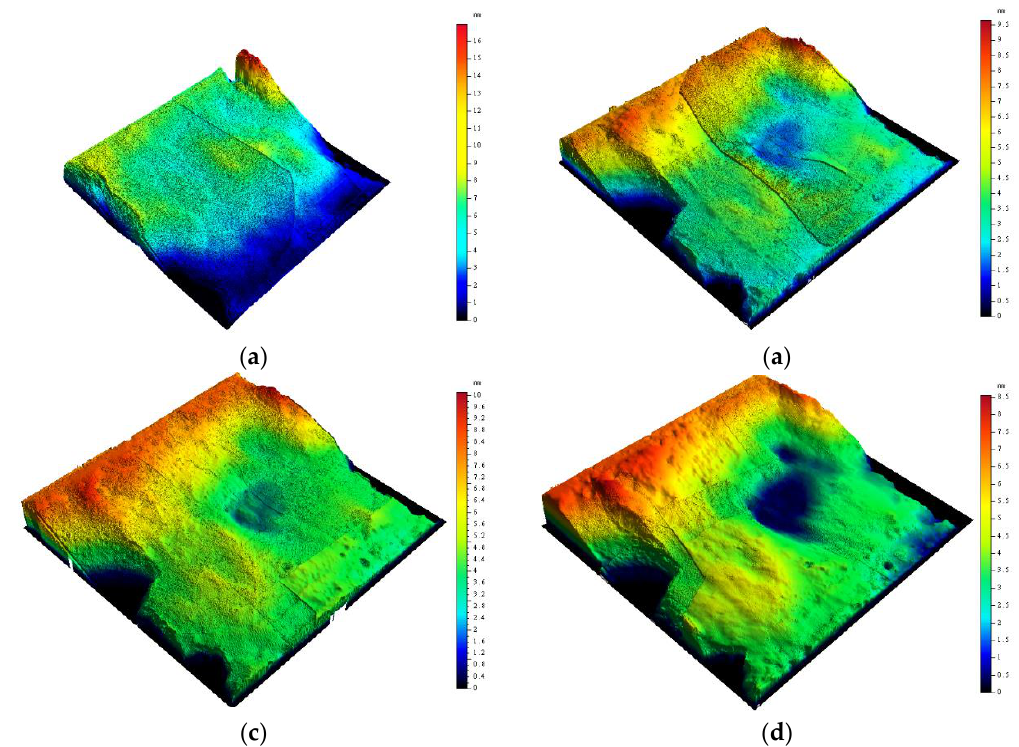
Figure 12. The three-dimensional scanning of CD-3 interface for each shearing. ( a ) Before shearing; ( a ) Before shearing; ( c ) Second shearing; ( d ) Third shearing. ( a ) Before shearing; ( c ) Second shearing; ( d ) Third